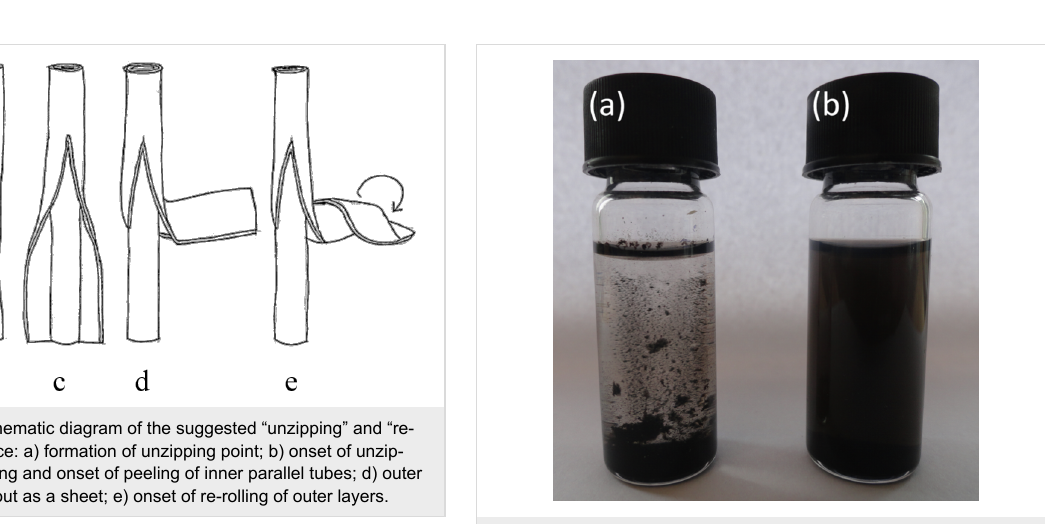
The unzipping and re-rolling process appears to reduce the number of walls on the MWCNTs compared to those for the as-received tubes (Figure 1d) and it is also possible that some of the tubes re-roll to form carbon nano-scrolls (CNS) [35,38-40]. This possibility is evidenced in Figure 3c where the number of walls of the three parts of the “T” pattern does not meet the “Russian Doll” MWCNTs requirement of N (left) = N (right)